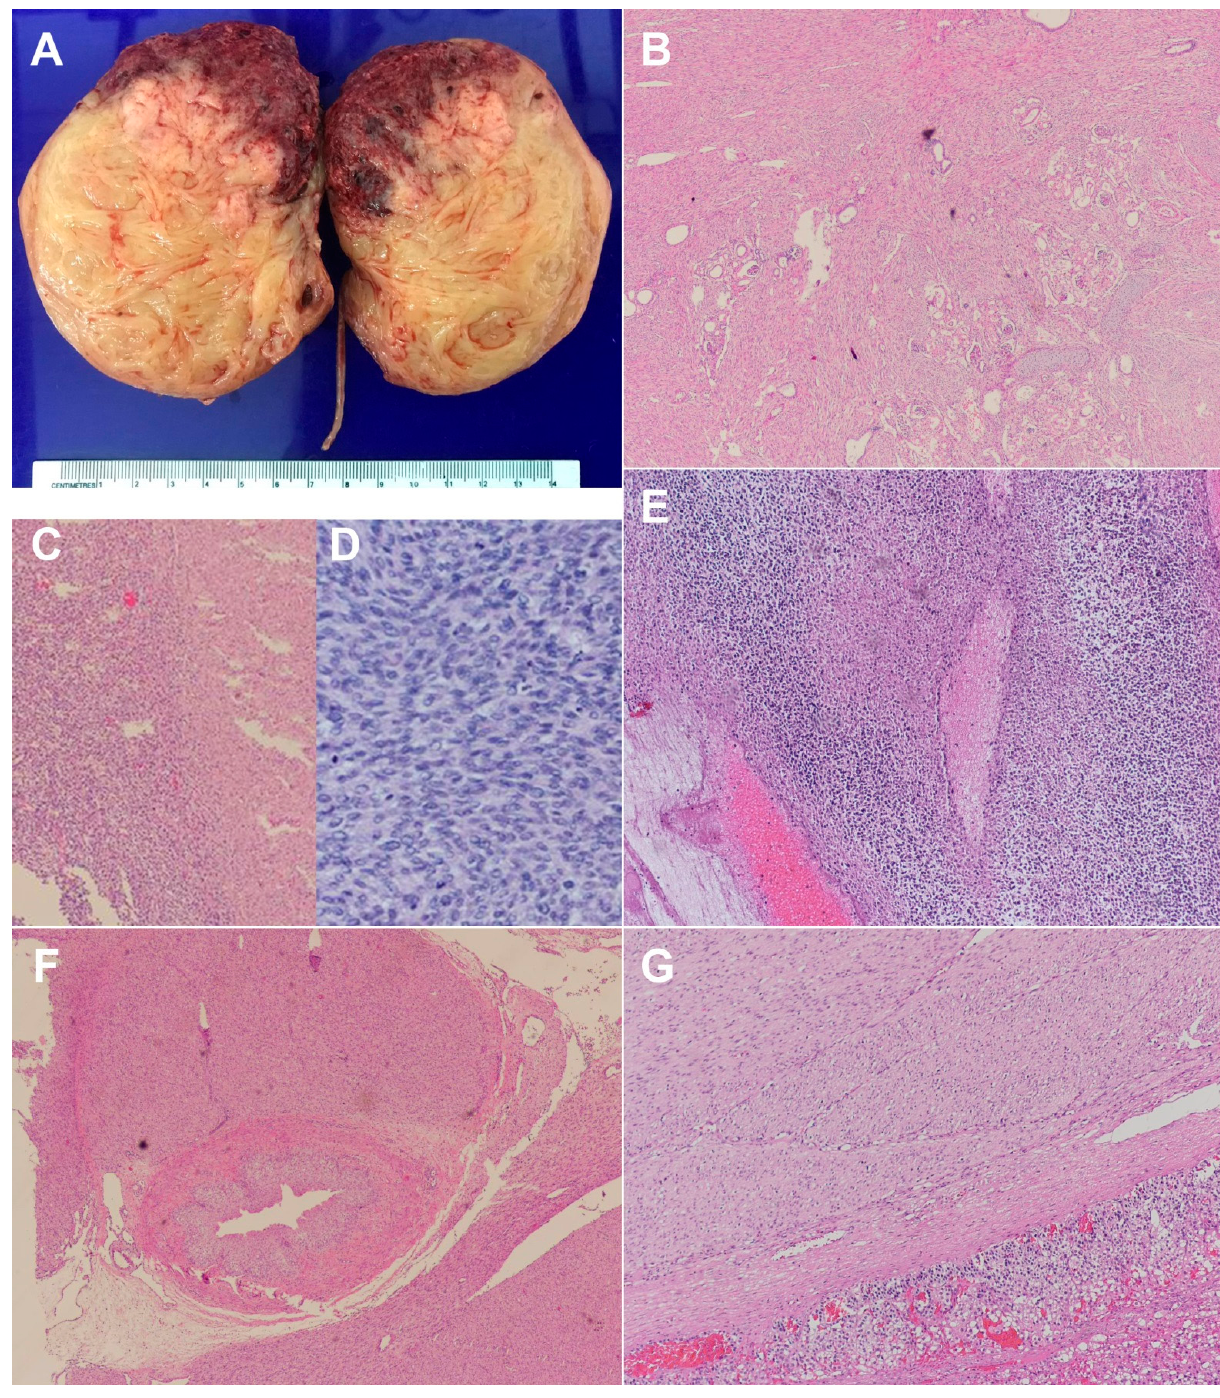
Figure 2. ( A ): The mass showed a white–tan, firm, whorled appearance with a poorly defined border. The superior portion of the mass revealed a softer consistency with hemorrhage. Normal renal parenchyma was seen medially; ( B ): (4× magnification) Classic-type, bland spindle cells ar- ranged in intersecting fascicles with entrapped renal parenchyma and islands of cartilage; ( C ): (10× magnification) Junction between classic type (right portion) and cellular type (left portion); ( D ): (40× magnification) Cellular-type, plump spindle cells with high mitotic activity arranged in sheet- like growth pattern; ( E ): (10× magnification) Tumor necrosis; ( F ): (4× magnification) Tumor in- volved renal sinus soft tissue close to the ureter; ( G ): (10× magnification) Tumor involved adrenal capsule.